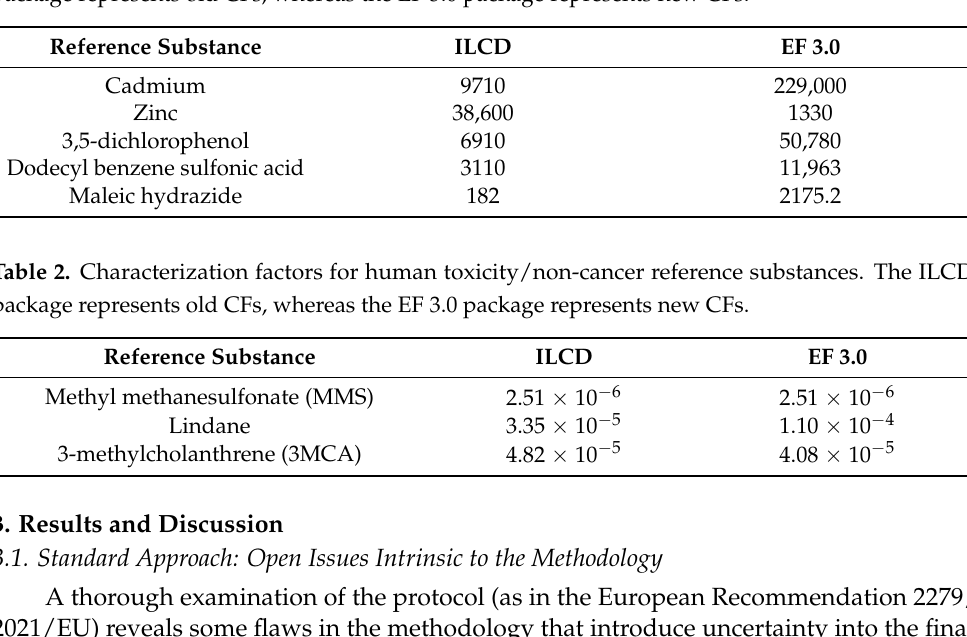
Table 1. Characterization factors for the freshwater ecotoxicity reference substances. The ILCD package represents old CFs, whereas the EF 3.0 package represents new CFs.